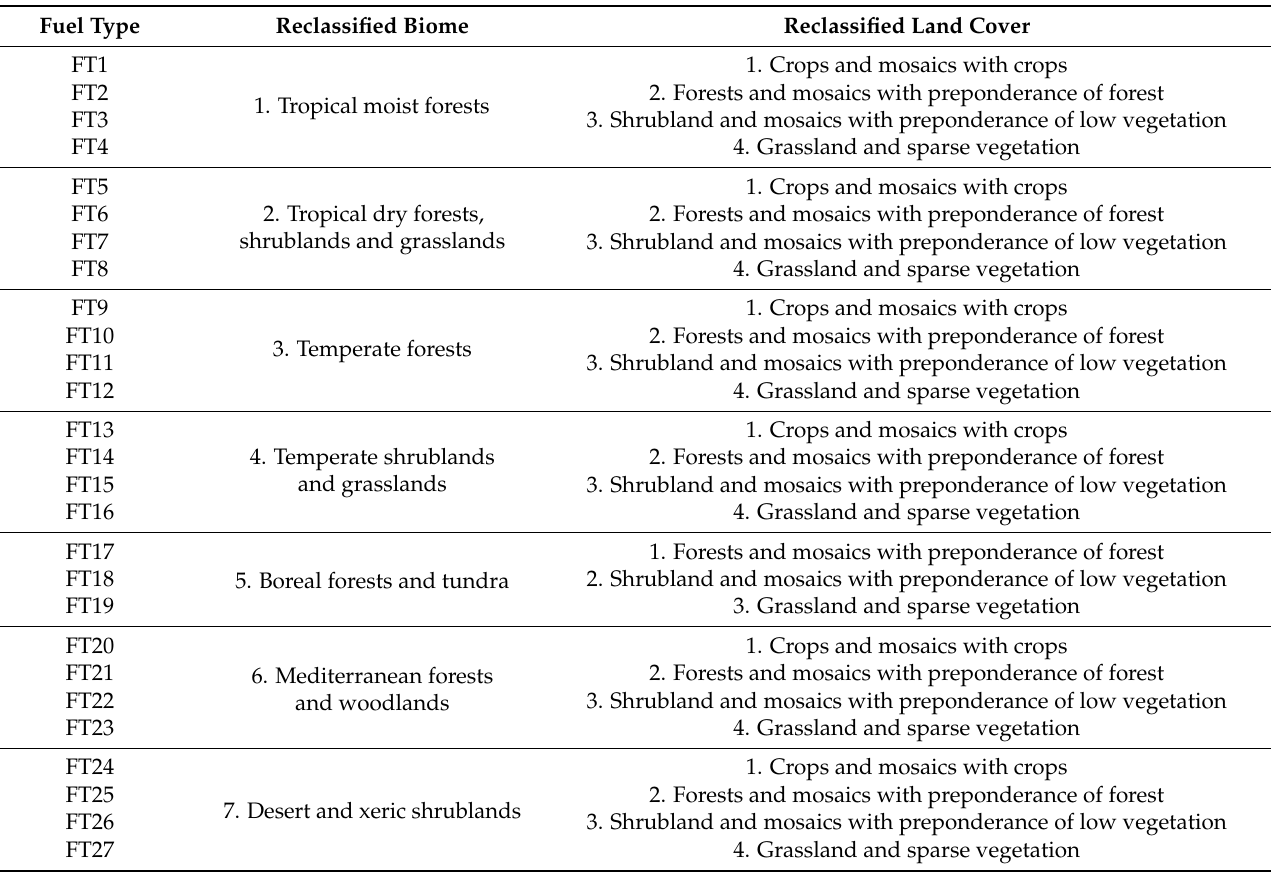
Table 1. Biome and land cover combination of the fuel types analyzed in this